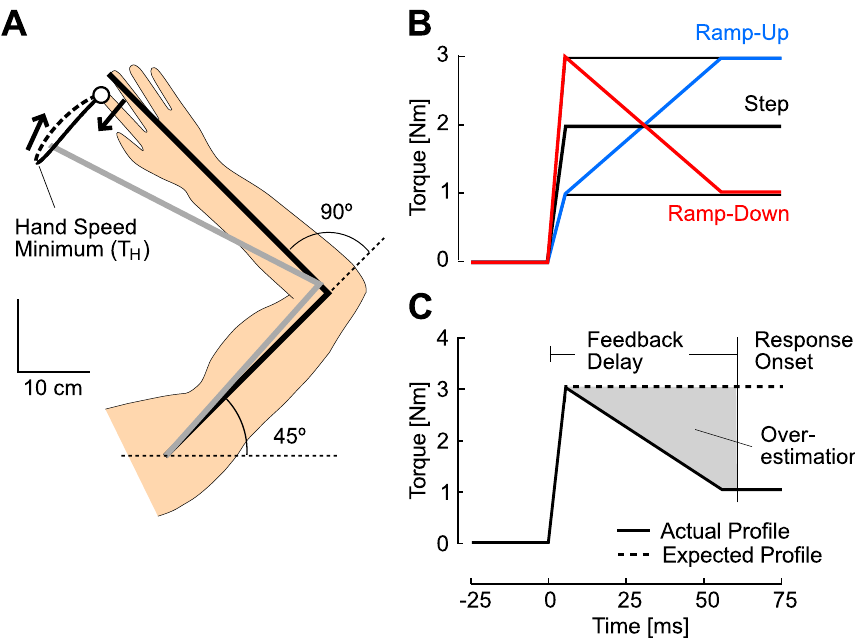
Figure 3. Procedures and perturbations. A: Overhead representation of the initial joint configuration and of a typical perturbation related movement. The initial joint configuration is shown in black. Hand path from perturbation onset until the first hand-speed minimum (T H ) is represented in solid trace. The remaining portion of the corrective movement is shown in dashed trace. B: Illustration of the different torque profiles: black traces illustrate the step perturbations (1 Nm and 3 Nm are displayed with thin traces), ramp-down perturbations in red and ramp-up perturbations in blue. C: Schematic representation of the effect of a ramp-down perturbation profile on the state estimation: the overestimation (gray region) result from the difference between the expected perturbation profile (step-function, dashed) and the actual perturbation (solid). The ramp- down profile was designed to produce an overestimation as illustrated in Figure 1 C. The opposite reasoning applies to ramp up-perturbation that produces an underestimation of the present state of the joint.